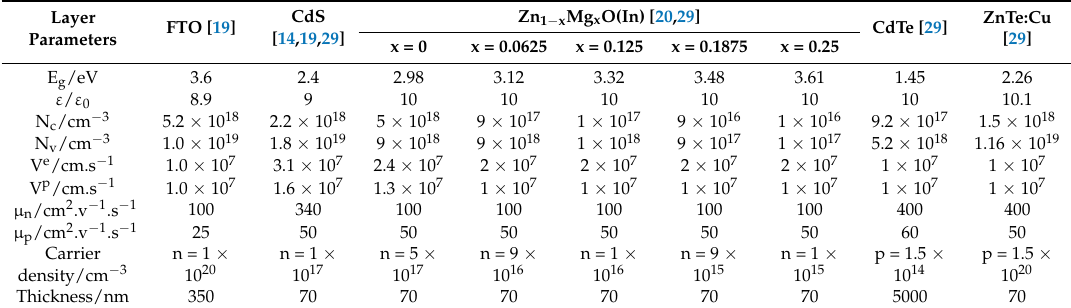
Table 1. Simulation parameters for the models of CdS/CdTe and ZMO:In/CdTe solar cells using SCAPS. Layer